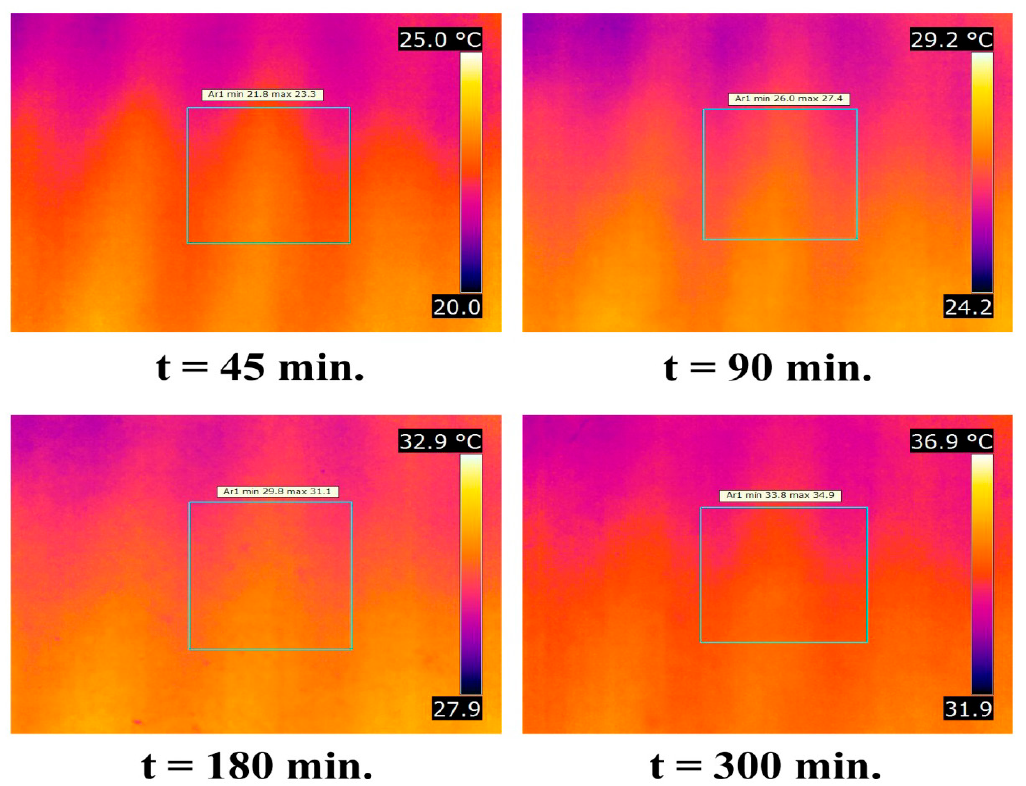
Figure 5. Thermograms of the portion of floor analysed in different instants of the